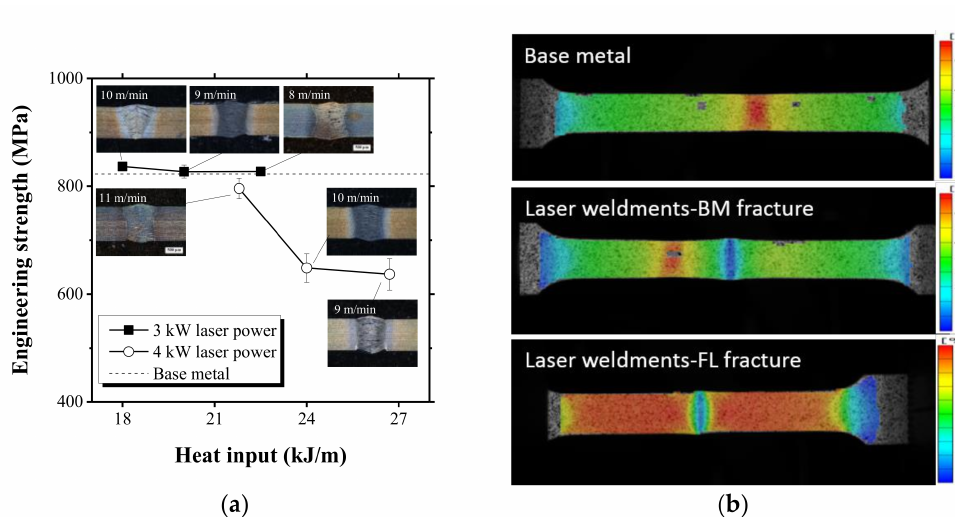
Figure 1. ( a ) Measured engineering tensile strengths; and ( b ) strain maps from digital image correlation (DIC) measurements at different failure locations. Laser welds that ruptured at base metal were produced using a laser power of 3 kW and welding speed of 8 m/min, while specimens that fractured at the fusion line were produced using a laser power of 4 kW and welding speed of 10